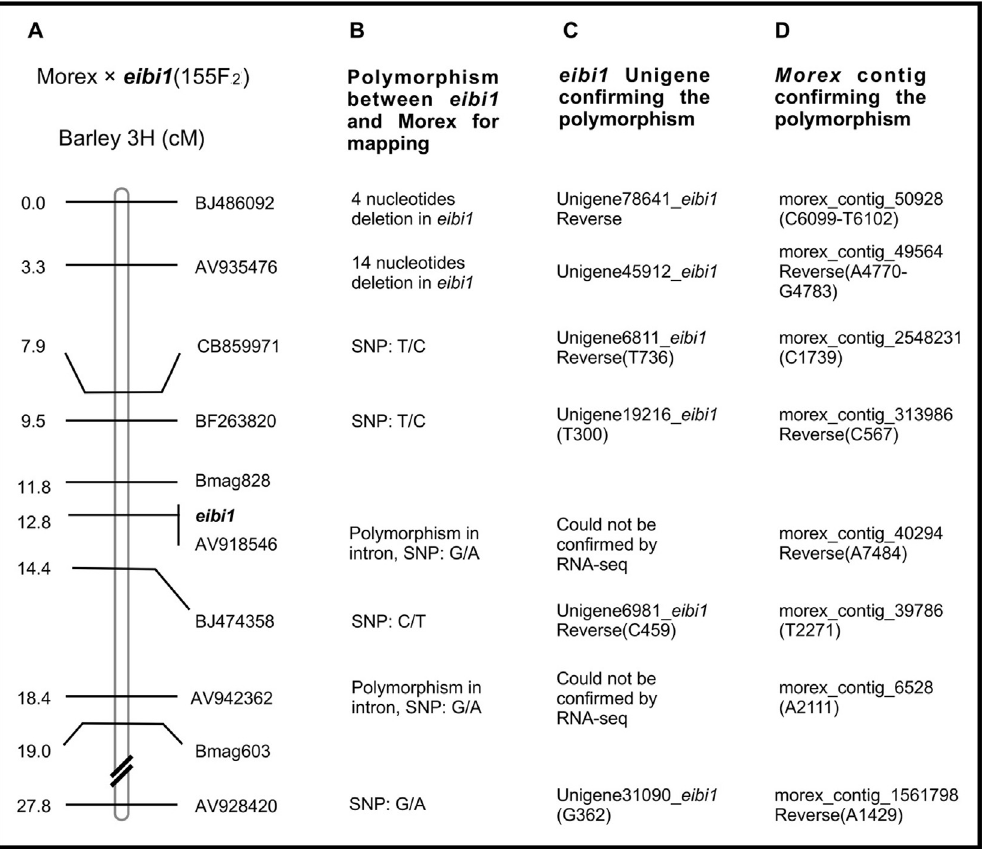
Figure 3 - An example of marker development by RNA-Seq. (A) eibi1 genetic map. Bmag828 and Bmag603 are SSR markers. The others are EST mark- ers. A total of 155 F 2 individuals derived from the cross of Morex eibi1 were used for the genetic mapping. The numbers at the left side indicate genetic distances in centimorgan (cM). (B) Corresponding marker polymorphism between parental line Morex and eibi1 . The polymorphisms were identified by PCRsequencingagainstparentalgenomicDNA.(C)Corresponding eibi1 Unigenes(derivedfromRNA-Seq)fortheESTmarkers.Insidetheparenthesis is a nucleotide followed by its position in the corresponding Unigene sequence. (D) Corresponding Morex contigs for the EST markers were retrieved from the database: assembly3_WGSMorex_renamed_blastable_POPSEQ.fasta (http://webblast.ipk-gatersleben.de/barley). Inside the parenthesis is a nucleotide followed by its position in the corresponding contig